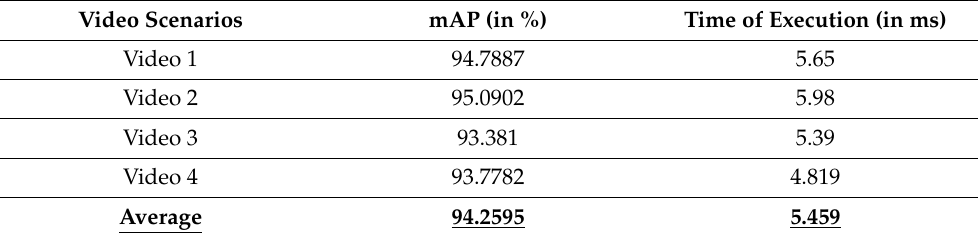
Table 4. Performance of the TSR algorithm over various KITTI dataset videos. Video